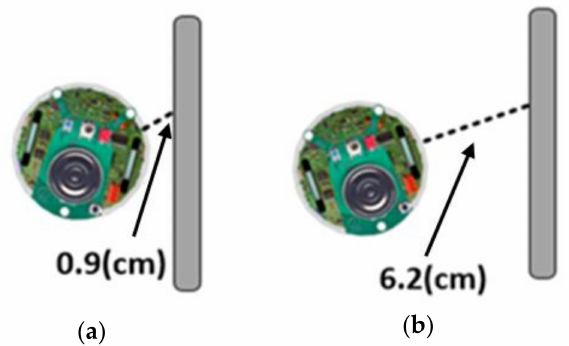
Figure 10. ( a ) Robot hits the wall; ( b ) Robot deviates from the